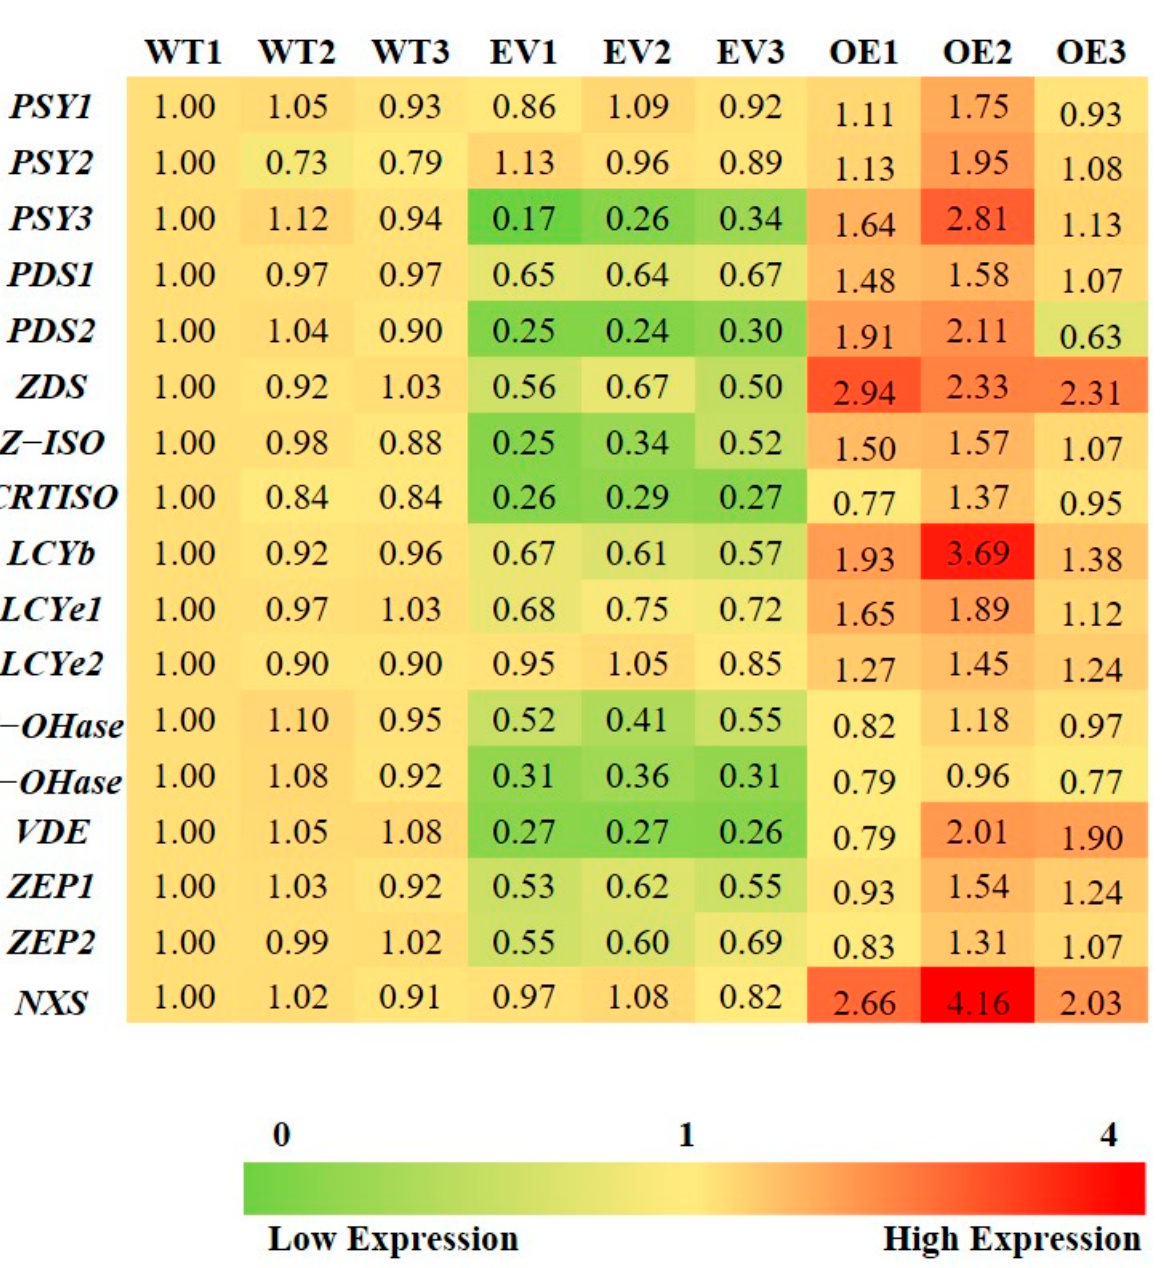
Figure 6. Heat map of carotenoid biosynthetic gene expression in wild-type (WT), the agroinfiltrated plants with empty vector (EV), and the BoaNXS -overexpressed plants (OE) in Chinese kale. Samples of leaves were taken from the control (WT), EV, and OE plants at the second day after the last injection. Abbreviations: GGPP, geranylgeranyl diphosphate; PSY , phytoene synthase; PDS , phytoene desaturase; ZDS , ζ -carotene desaturase; Z-ISO , ζ -carotene isomerase; CRTISO , carotenoid isomerase; LCYe , lycopene ε -cyclase; LCYb , lycopene β -cyclase; ε -OHase , ε -carotene hydroxylase; β -OHase , β -carotene hydroxylase; VDE , violaxanthin de-epoxidase; ZEP , zeaxanthin epoxidase; NXS , neoxanthin synthase.